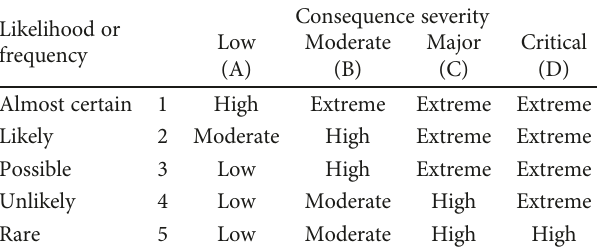
Table 2: Risk matrix diagram for potential risk screening. Likelihood or